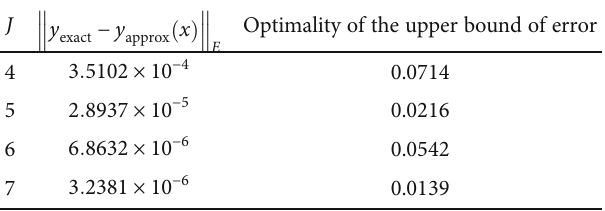
Table 1: Optimal value of the upper bound of error at di ff erent J and α = 0 : 25 .